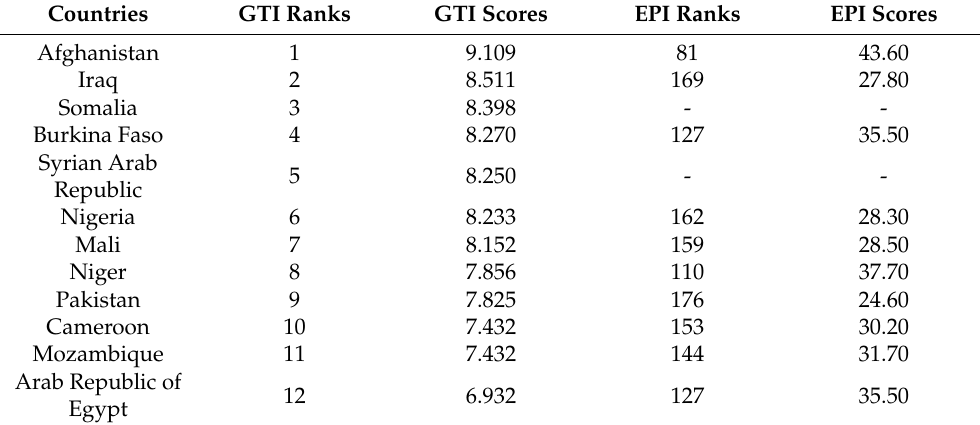
Table 1. Scores of the